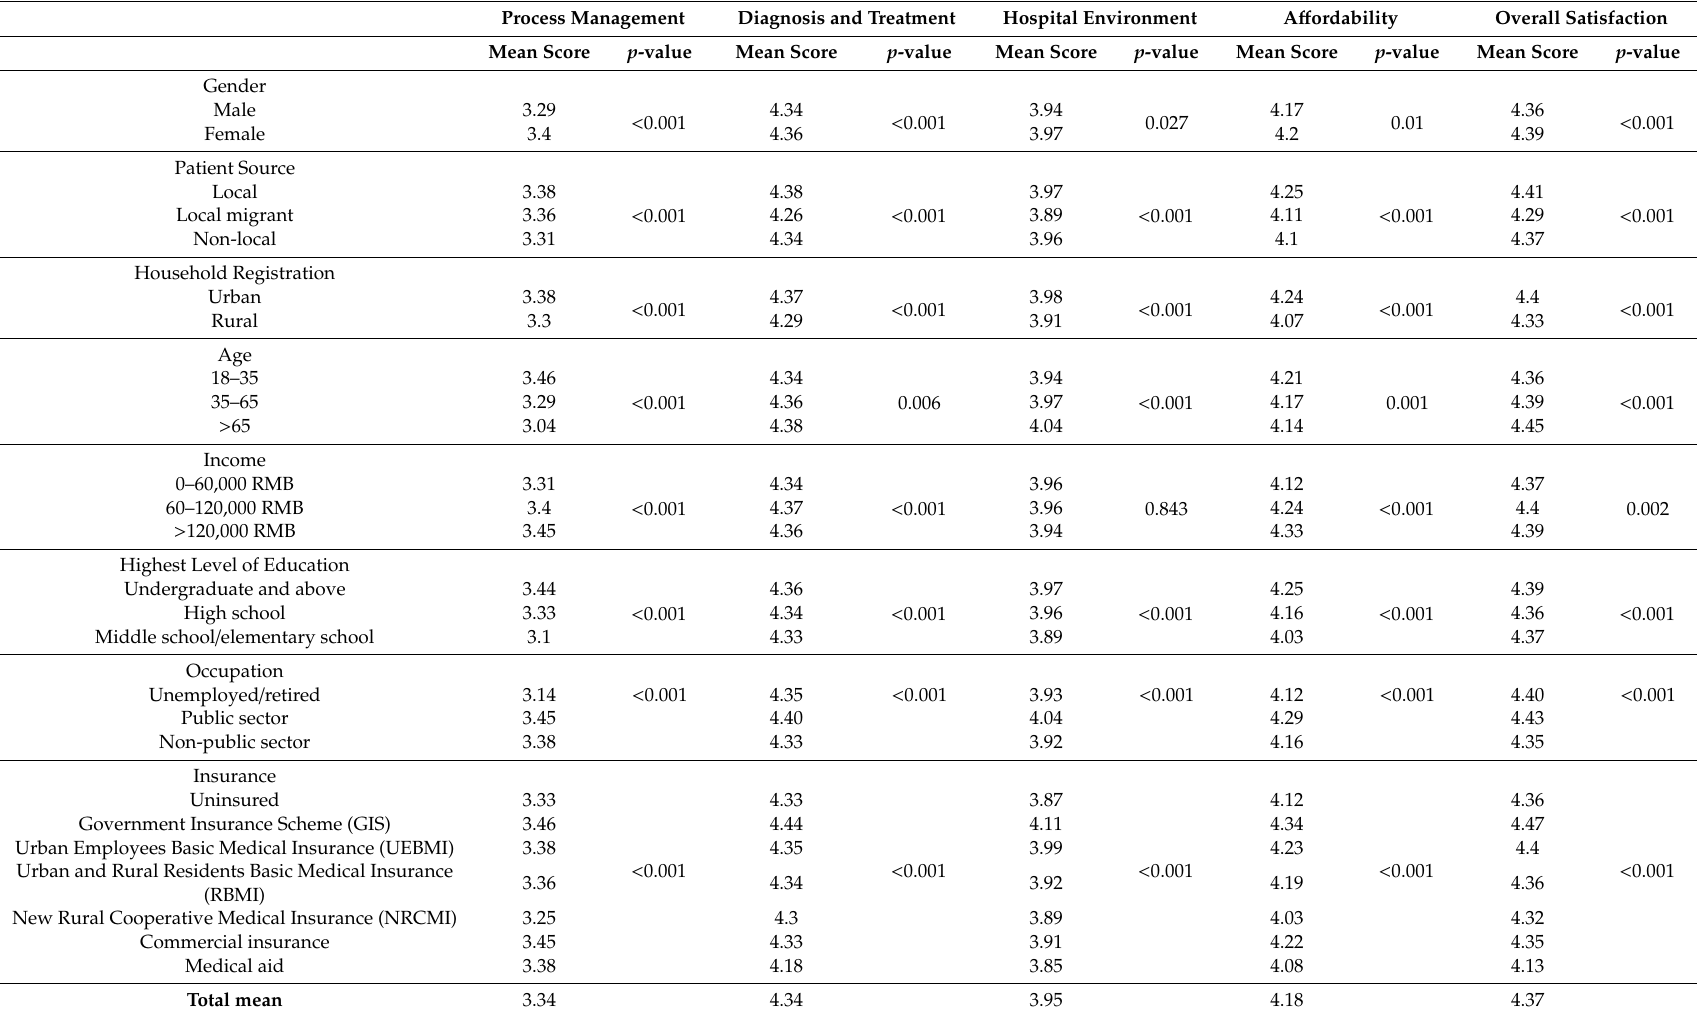
Table 3. Mean domain scores (ANOVA p -values reported, p -value < 0.05 considered statistically